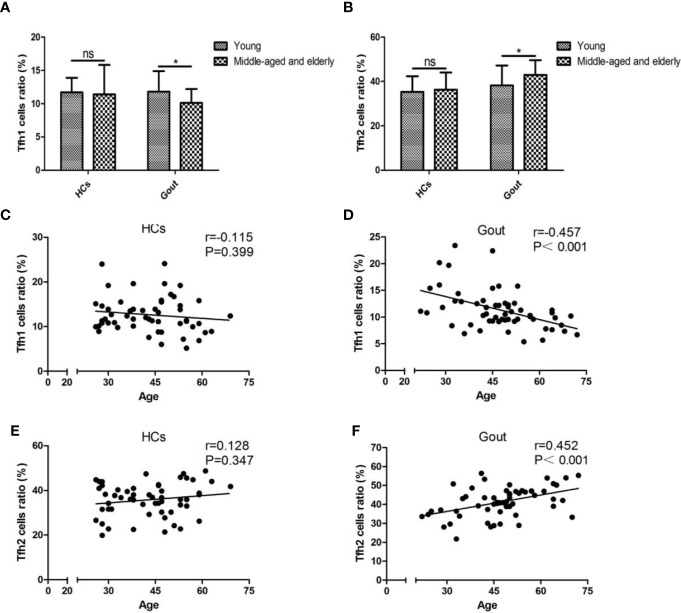
Tfh1/Tfh2 cell subsets are age-specific in gout patients. (A, B) The abundances of Tfh1 and Tfh2 cells are compared by t test for parametric data and the nonparametric Wilcoxon rank sum test between young and middle-aged and elderly populations in the HC and gout groups. Pearson or Spearman correlation analysis shows that unassociated with HCs expressing Tfh1 cells (C), age inversely correlated with Tfh1 cells of gout patients with a pronounced significance, P < 0.001 (D). Age has no significant association with Tfh2 cells of HCs, P=0.347 (E), whereas they are positively interrelated in the gout group, P < 0.001 (F). HCs, healthy controls; ns, not significant. *P < 0.05.